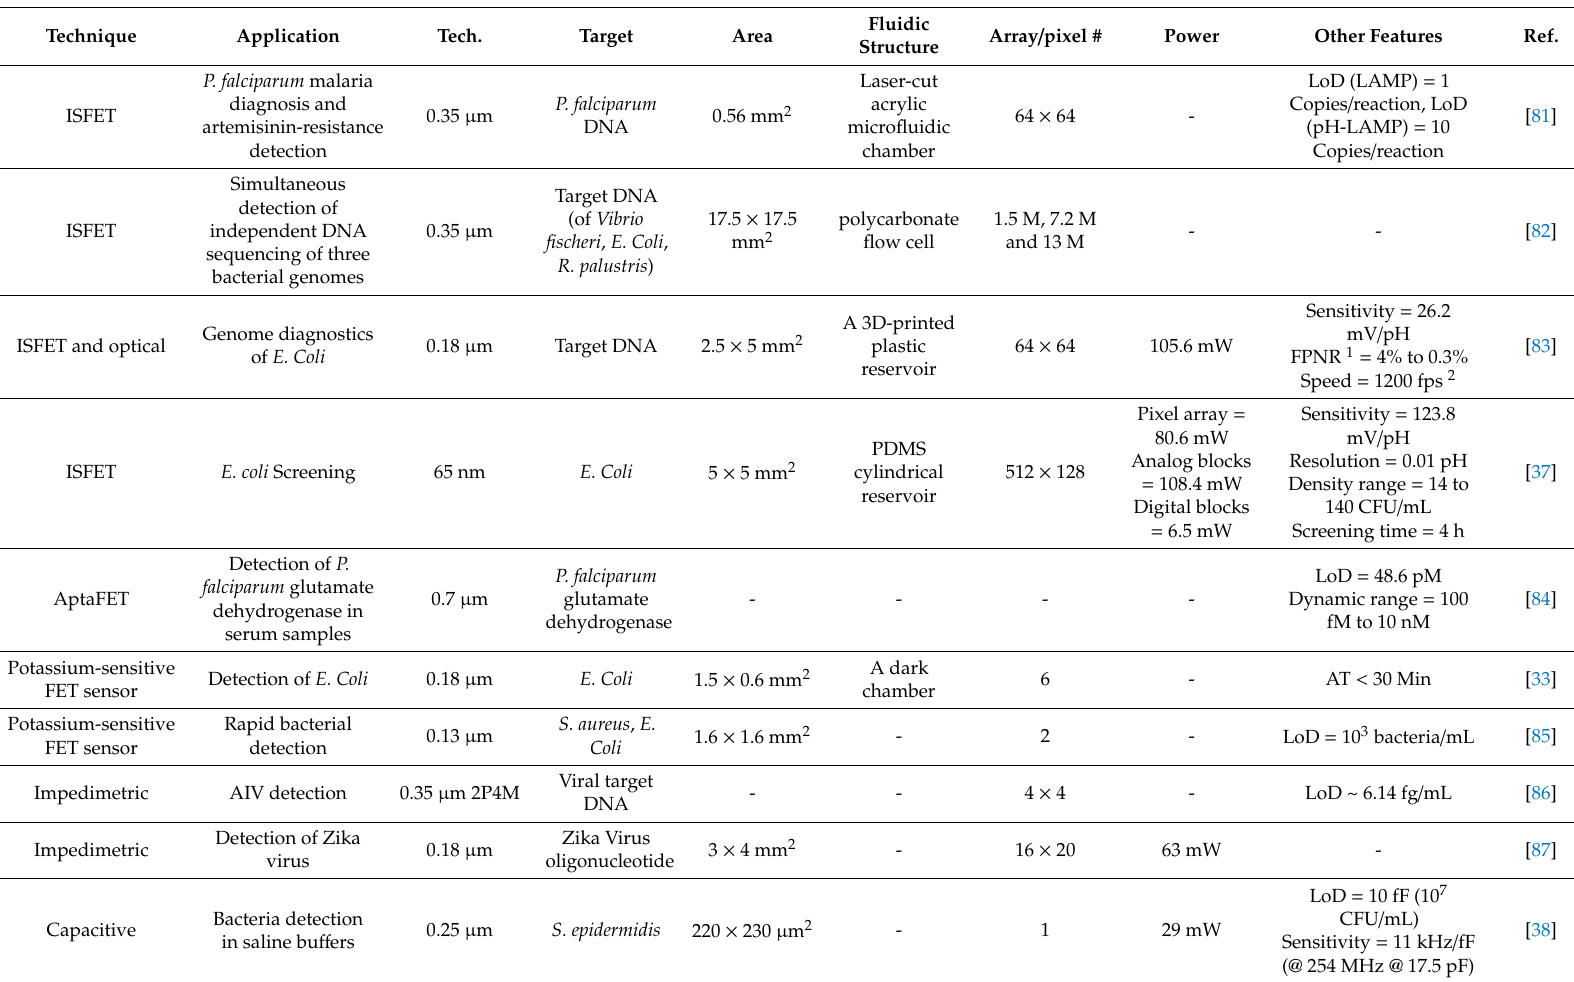
Table 4. CMOS-based electrochemical sensors reported for the diagnosis of various infectious